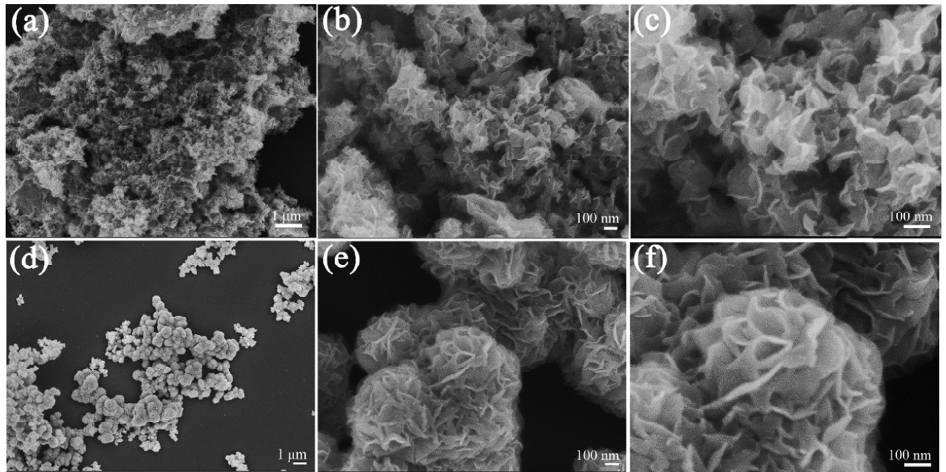
Figure 1. FESEM images of MoS 2 nanosheets ( a – c ) and MoS 2 nanoflowers ( d – f ) at different mag- nifications. Reprinted (adapted) with permission from Reference [74], Copyright (2019), American Chemical Society.